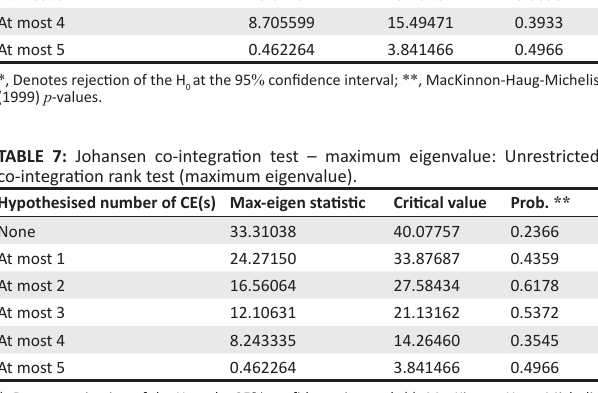
TABLE 6: Johansen co-integration test – trace test: Unrestricted co-integration rank test (trace). Hypothesised number of cointegrating equation(s)